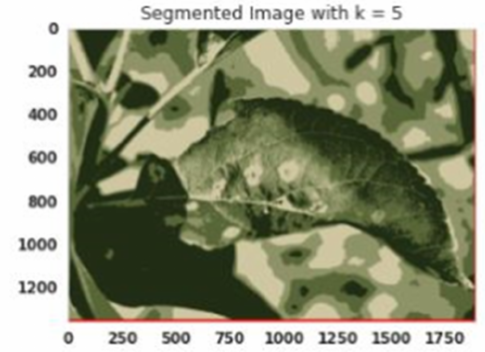
Figure 8. Image Segmentation Using K-means